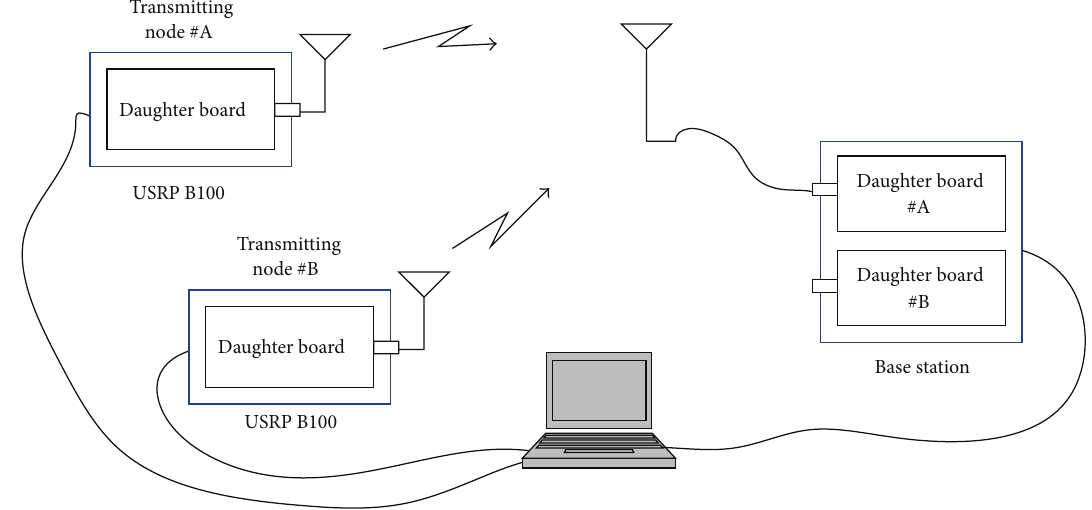
Figure 14: Configuration of measurement for BER.